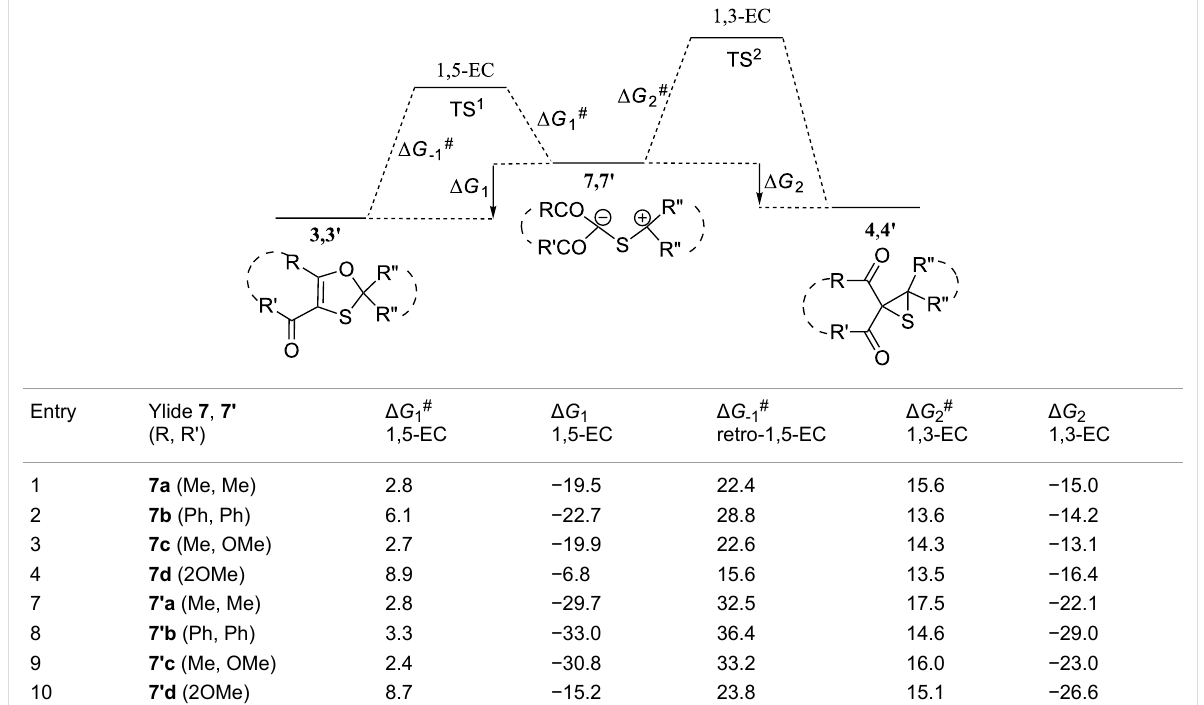
Table 3: Calculated relative energies for competitive 1,5- and 1,3-electrocyclizations of thiocarbonyl ylides 7 and 7' on the potential energy surface (in kcal·mol − 1 ). a